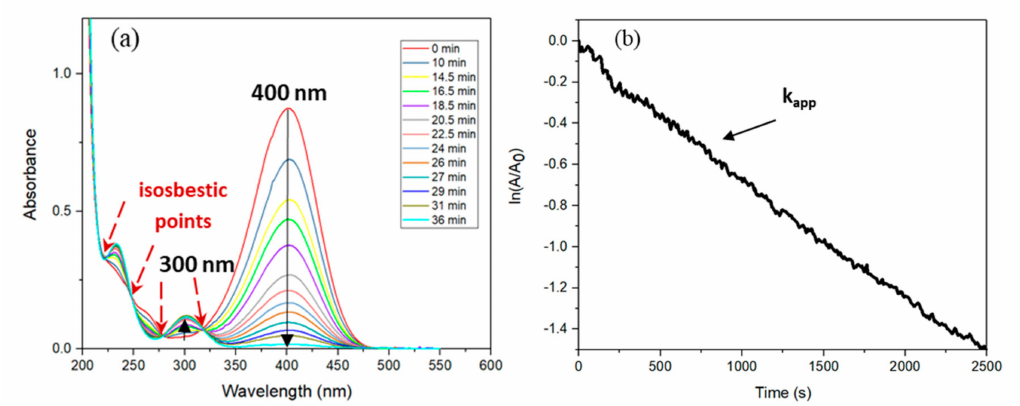
Figure 3. ( a ) Following UV–vis absorption spectra (6 s intervals) for the catalytic reduction of 4-Nip using Pd nanoparticles (pH = 10). ( b ) Absorption dependence of the time for the reduction of 4-Nip. Conditions: [4-Nip] = 7.38 × 10 − 5 M; [NaBH 4 ] = 1.11 × 10 − 2 M (150 eq (equivalent)); [Pd] = 2.8 × 10 − 5 M (0.249 mol% Pd); T = 23.7 ◦ C. ( k app = 0.0006 s − 1 ).